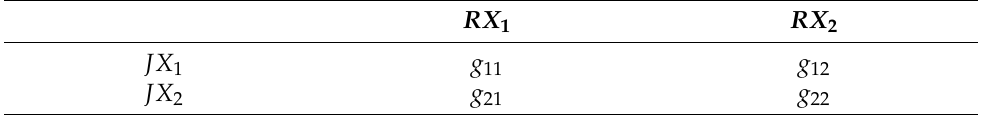
Table 4. Definition of complex channel gain between the interference and receive